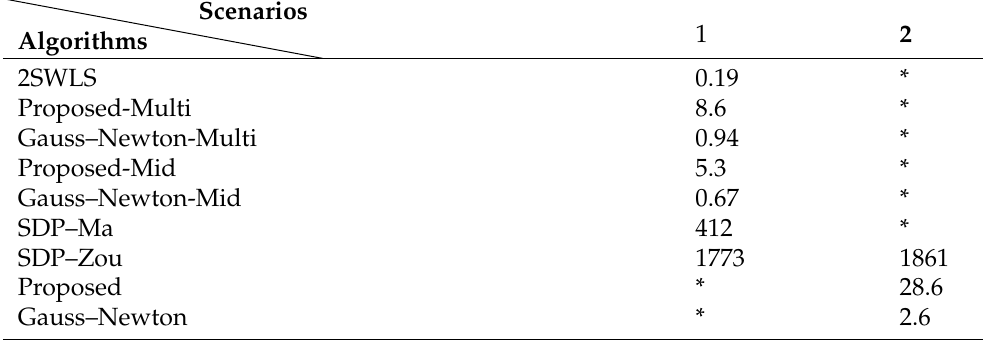
Table 1. The average running time [ms] of the considered algorithms with the two scenarios, in which a star denotes that the algorithm is not fitting for a certain scenario. CPU: i7-8700 3.2 GHz. Algorithms